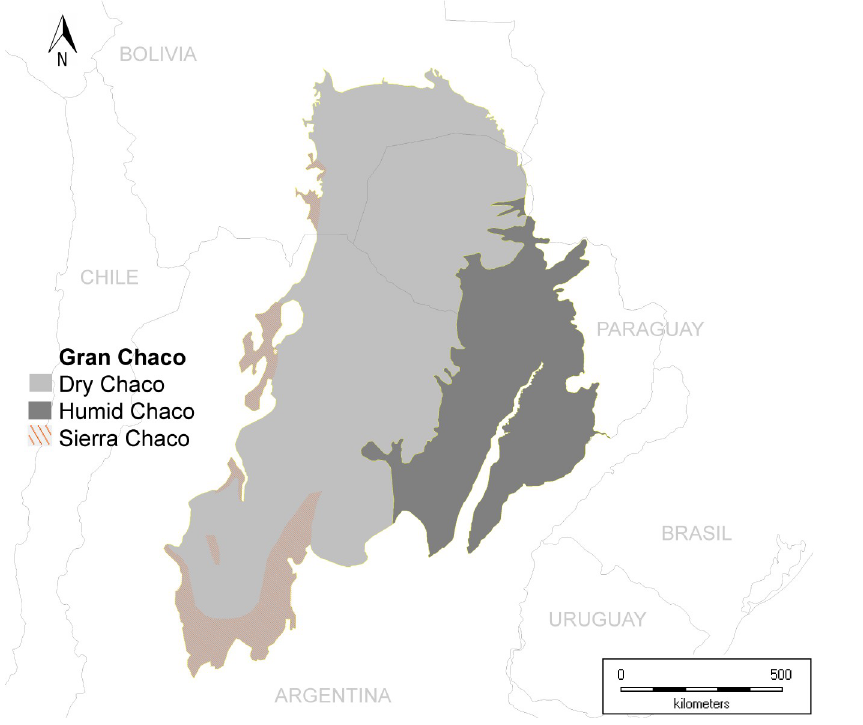
Fig 1. Delimitation of the Gran Chaco ecoregion and